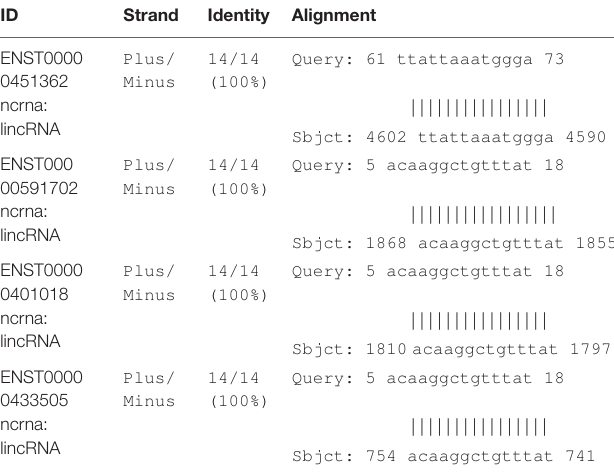
TABLE 7 | List of INPP5B possible binding candidates of